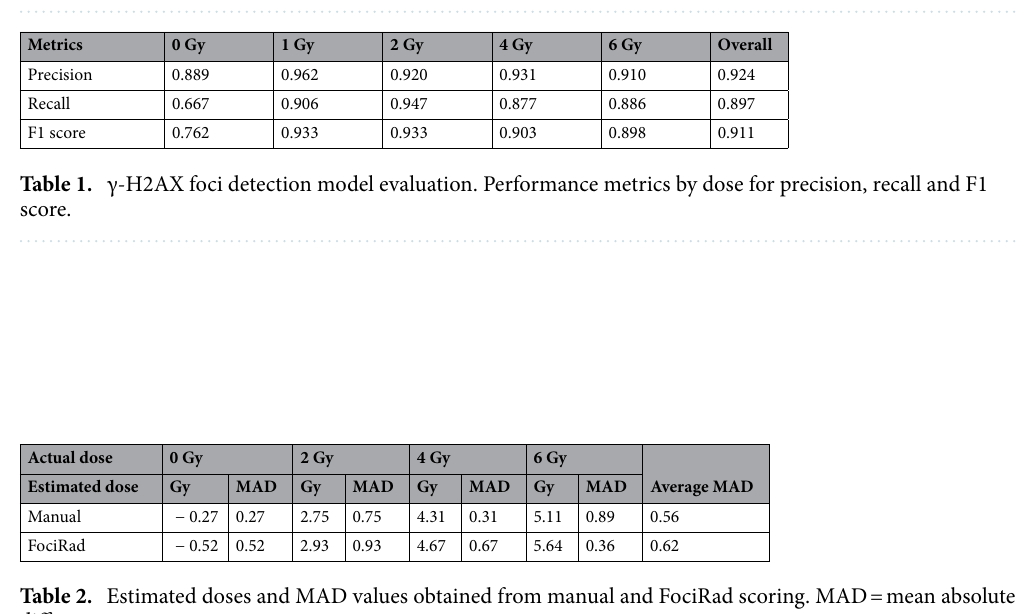
Figure 5. FociRad implementation process. Three-channel z-stack images were analyzed by D1-weighted for mononuclear cell (MNC) recognition and cell cropping. Green channel extraction was performed to show only γ-H2AX foci. Green channel images were analyzed by D2-weighted for foci detection. Foci were automatically counted and the numbers of foci per cell were used to calculate dose by linear fitting to the established dose– response calibration curves.